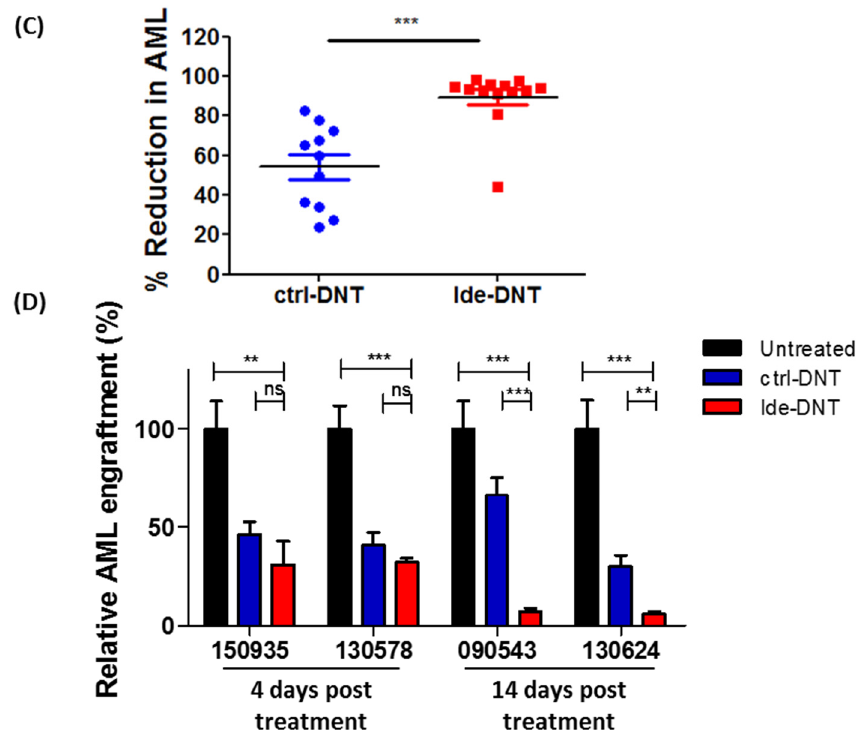
Figure 2. Ide significantly enhances the anti-leukemic function of DNTs in PDX model. ( A ) Schematic diagram of patient-derived xenograft (PDX) model used. Sublethally irradiated NSG mice were infused with 2–3 × 10 6 primary AML patient sample on day 0. On day 17 and 20, mice were infused with 2 × 10 7 ctrl-DNTs or Ide-DNTs. Mice were sacrificed and AML engraftment were assessed in various tissues on day 24 or day 34. ( B ) NSG mice engrafted with a primary AML sample (090543) were treated with PBS, ctrl-DNT, or Ide-DNT as described in Figure 2A. AML engraftment and counts in bone marrow were assessed on day 34. Representative flow plots show AML engraftment (CD45 + CD33 + ) in the BM. Dot plot shows the frequency and number of AML cells engrafted in the BM. Horizontal line represents the mean of BM AML engraftment level, each symbol represents individual mice, and error bars represent SEM. The results shown are representative of two independent experiments. ( C ) Percent reduction in AML engraftment from two PDX experiments performed using different primary AML patient samples (090543 and 130624). Horizontal bar represents the mean of reduction in AML engraftment level in BM on day 34 relative to the untreated group in ctrl-DNT (blue)- and Ide-DNT (red)-treated groups. Each symbol represents individual mice and error bars represent SEM. ( D ) Sublethally irradiated (250 cGy) NSG mice were engrafted with one of four primary AML samples (sample ID: 150935, 130578, 090543, and 130624; 2–3 × 10 6 cells/mouse). Subsequently, mice were treated with PBS (black) or 1.5–2 × 10 7 cells per infusion of ctrl-DNTs (blue) or Ide-DNTs (red) on day 17 and 20. For the PDX model using the sample IDs 150935 and 130578, BM AML engraftment was assessed on day 24, which was 4 days post-treatment. For the sample IDs 090543 and 130624, BM AML engraftment was assessed on day 34, which was 14 days post-treatment. Each group had 4–8 mice. Horizontal bar represents the mean of BM AML engraftment level normalized to the untreated group, and error bars represent SEM. * p < 0.05, ** p < 0.01, *** p < 0.001 .